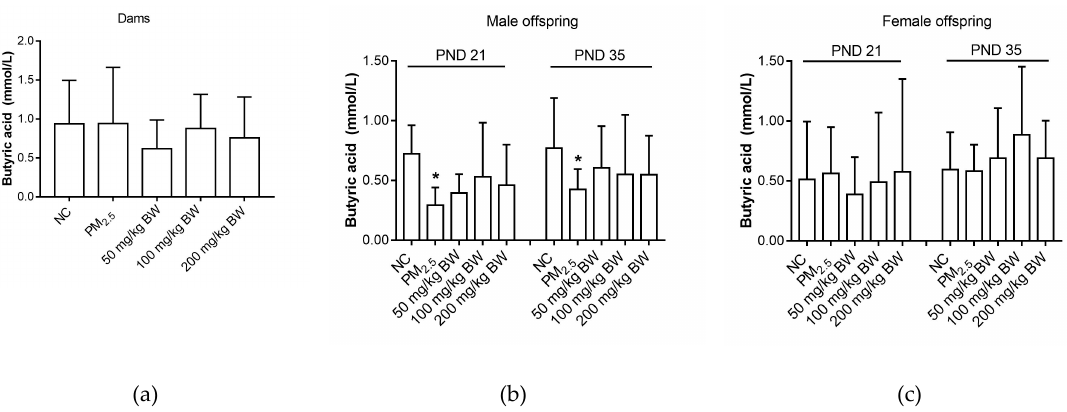
Figure 4. Butyric acid concentrations of dams and offspring. (a) Butyric acid of dams on PND 21. (b) Butyric acid of male offspring on PND 21 and PND 35. (c) Butyric acid of female offspring on PND 21 and PND 35. The data was expressed as mean ± SD of each group. Compared with the NC group, * indicates p < 0.05.